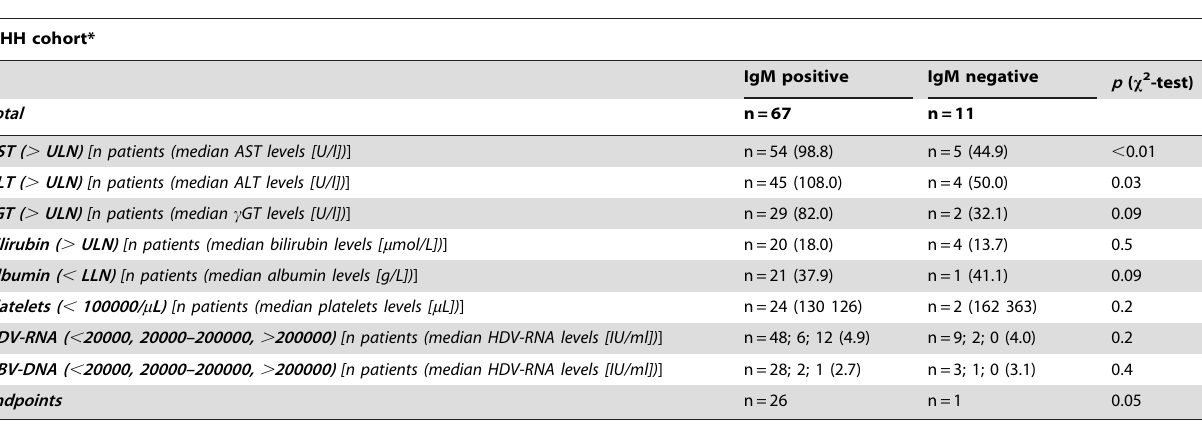
Table 3. Factors associated with anti-HDV IgM positive and negative values according to chi-square analysis in the MHH cohort.